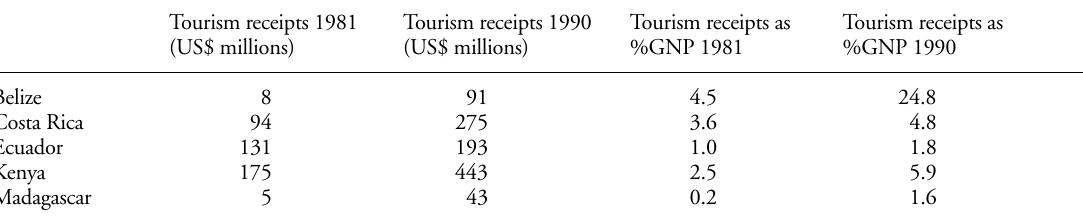
Table 1. Economic growth of the ecotourism industry in developing countries (GNP: Gross National